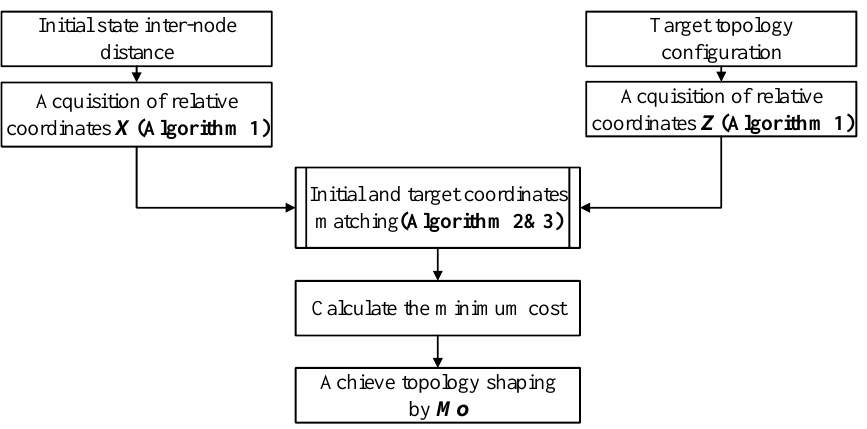
Figure 3. Flow chart of the proposed topology shaping method.